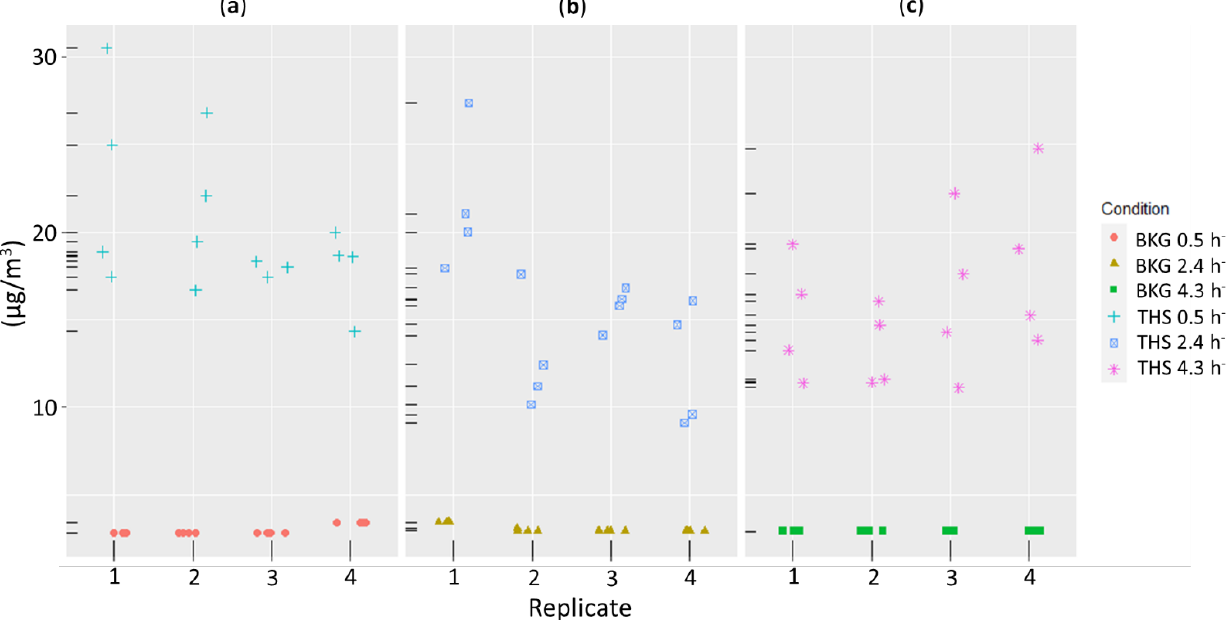
Figure 2. Comparison of the concentrations of airborne acetaldehyde (µg/m 3 ) in the background (BKG) and THS 2.2 use sessions (THS) under simulated ( a ) Residential category III (0.5 h −1 ), ( b ) Store (2.4 h −1 ), and ( c ) Restaurant (4.3 h −1 ) environ- ments.